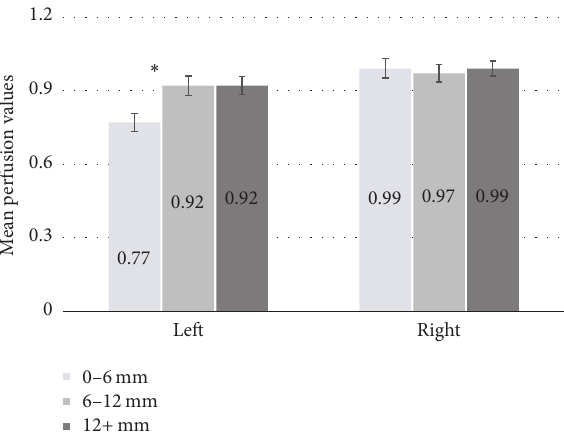
Figure 4: Mean right-occipital-normalized perfusion values for participants with aphasia for the left perilesional tissue and the corresponding right homologous regions in the 0–6mm, 6–12 mm, and remaining (12+mm) ROIs. Error bars are standard error. ∗ indicates a significant difference ( 𝑝 < .05 ). Significance is not indicated for left versus right differences (all ROIs are significant between